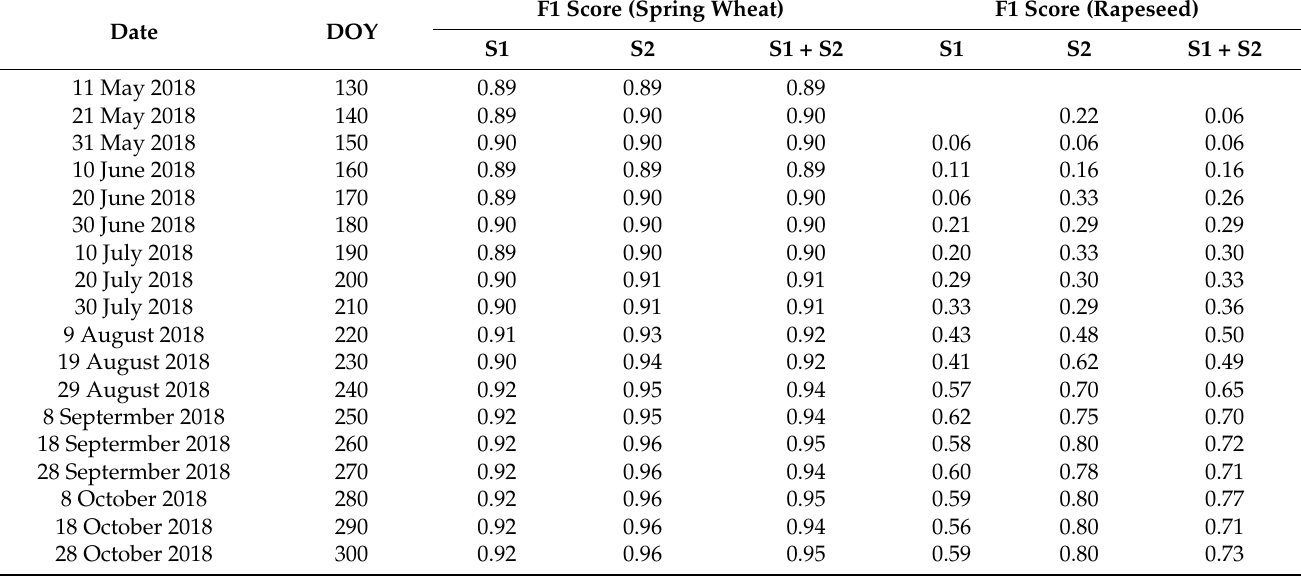
Table A2. F1-score values of spring wheat and rapeseed for the different classification